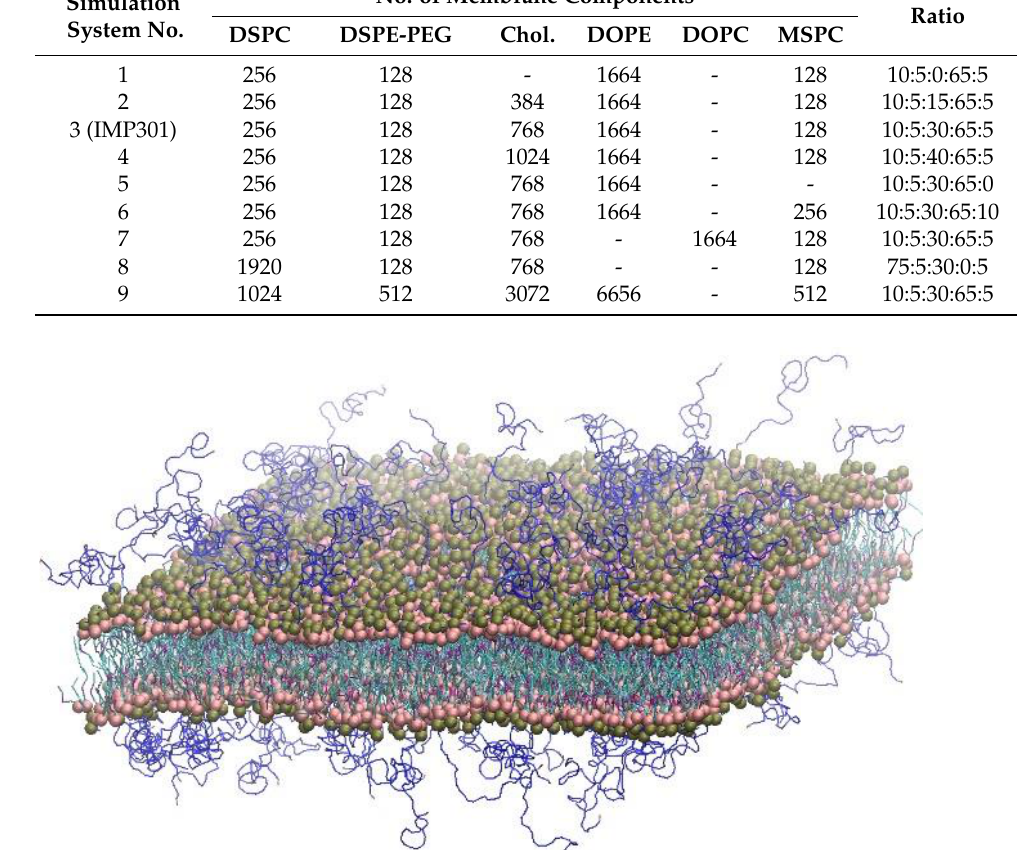
Table 1. List of simulations. Lipid ratios are represented as DSPC: DSPE-PEG: Chol.: DOPE (or DOPC): MSPC. Simulation System No.